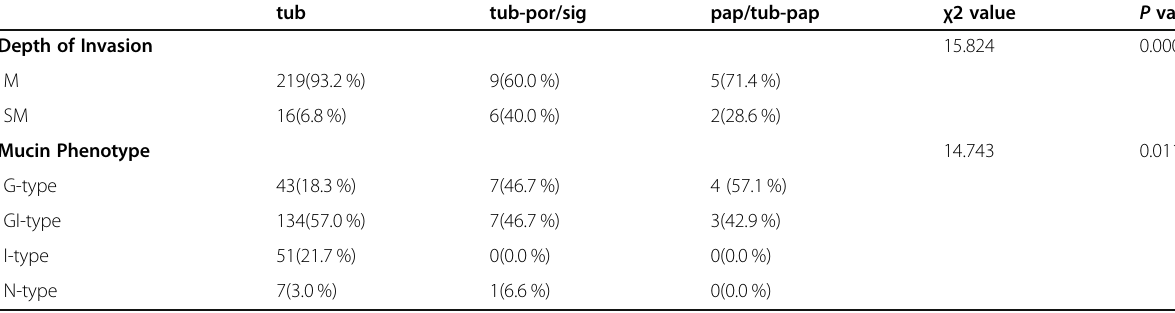
Table 3 Relationship between Biological Behavior and Mucin Phenotypes tub